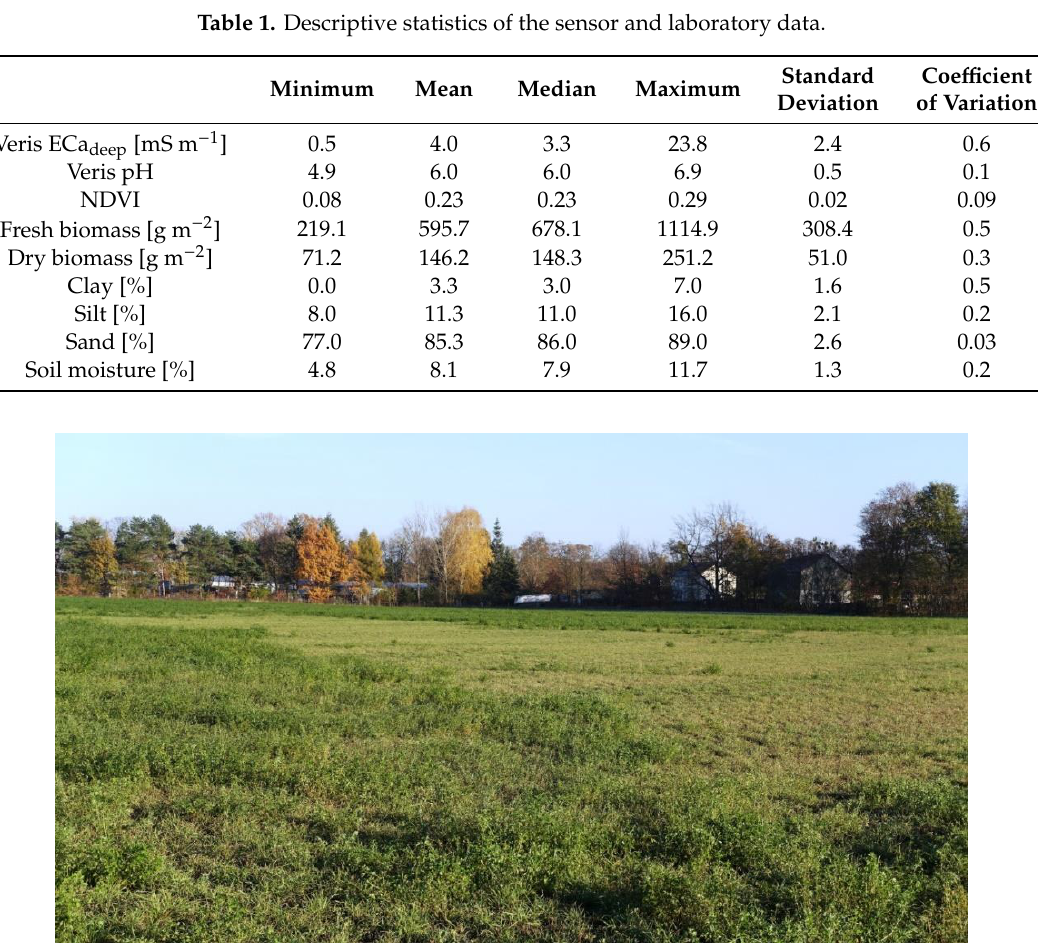
Figure 3. Visible small-scale variation of the grassland vegetation at Königsfeld. Alfalfa is dominant